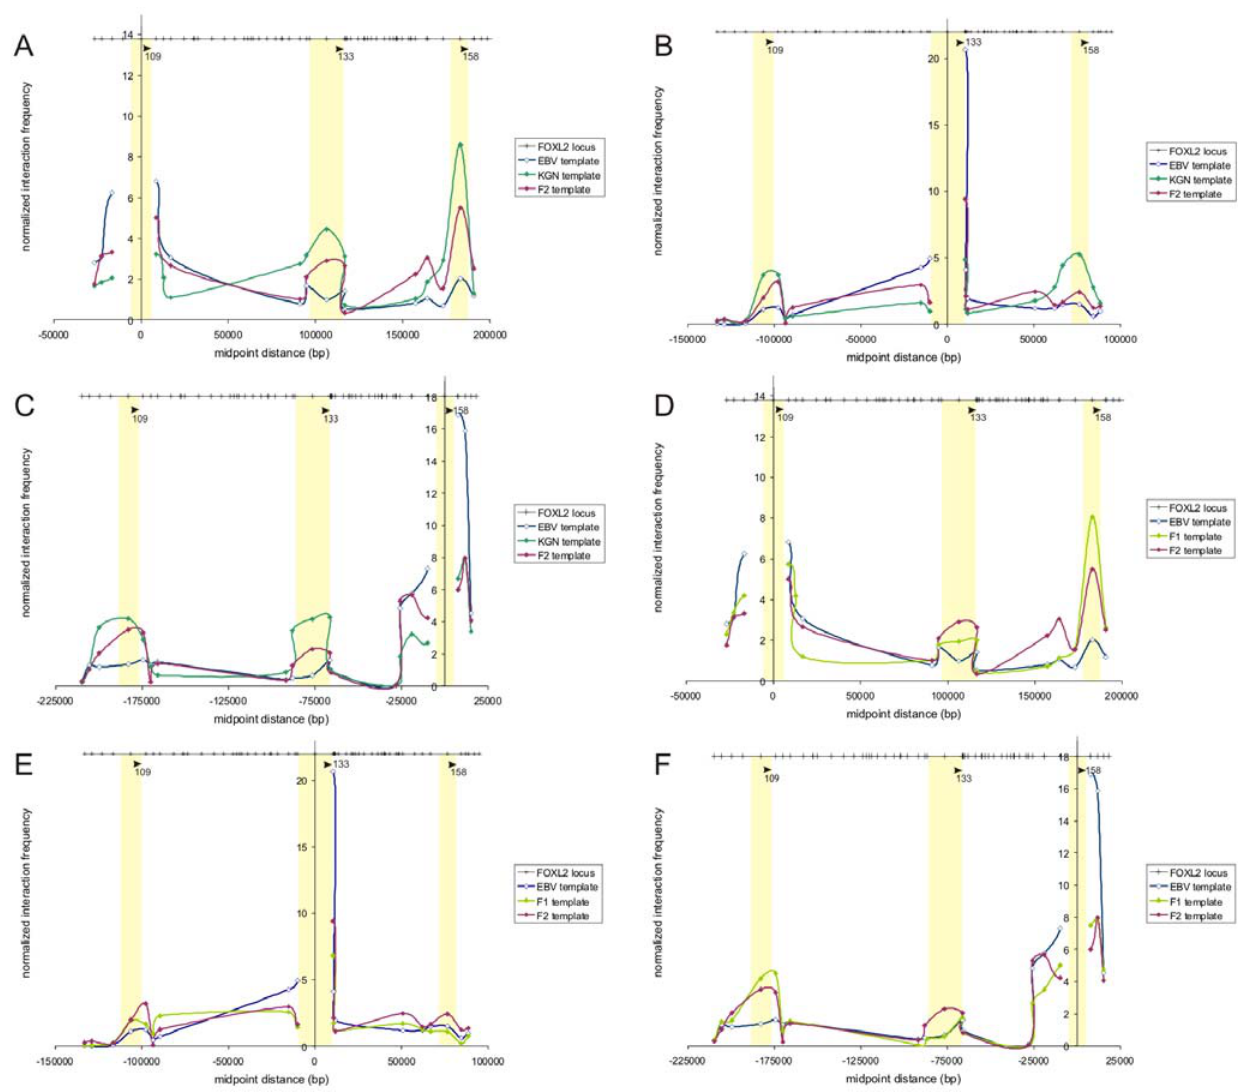
Figure 5. 3C analysis of FOXL2 region: mutual interactions between three regulatory sequences upstream of FOXL2 . (A–C) In a first step 3C analysis of the FOXL2 region demonstrated a close proximity of three evolutionarily conserved fragments 109, 133, and 158 with a fragment containing the FOXL2 core promoter in expressing cells (KGN and control fibroblasts F2) (Figure 1, Figure 2, and Figure S2). Fragment 133 contains the 7.4 kb deletion. Second, to validate mutual interactions between these three regulatory fragments, 3C was performed in non-expressing EBV and expressing KGN and F2 cells with fragments 109 (A), 133 (B) and 158 (C) as anchor fragments respectively. The X-axis shows the genomic positions relative to the respective anchor fragments 109, 133 and 158 respectively; the Y-axis indicates normalized interaction frequencies measured by semi- quantitative PCR. At the Y-axis there are no peaks in interaction frequencies because an anchor fragment cannot interact with itself. Regions of interaction are highlighted with yellow rectangles. In expressing cells, all three distant fragments mutually interact and contact the FOXL2 core promoter, assuming the intervening DNA loops out. Interaction frequencies between the FOXL2 promoter and the regulatory sequences (represented in Figure S2) are significantly lower compared to interaction frequencies observed amongst the interacting fragments themselves (A–C). (D–F) The X- axis shows the genomic positions relative to the respective anchor fragments 109, 133, and 158 respectively; the Y-axis indicates normalized interaction frequencies measured by semi-quantitative PCR. At the Y-axis there are no peaks in interaction frequencies because an anchor fragment cannot interact with itself. Regions of interaction are highlighted with yellow rectangles. Experiments with anchor primers 109, 133, and 158 respectively (D–F), revealed interaction comparable to those in EBV cells in the deleted region. Moreover, Figure 5D and 5F show that in F1 cells, restriction fragments 109 and 158 maintain their mutual interaction in spite of absence of interaction with fragment 133. This demonstrates that retained mutual interactions and interactions between fragments 109 and 158 and the FOXL2 core promoter are not sufficient for a normal cell- specific control of FOXL2 expression.